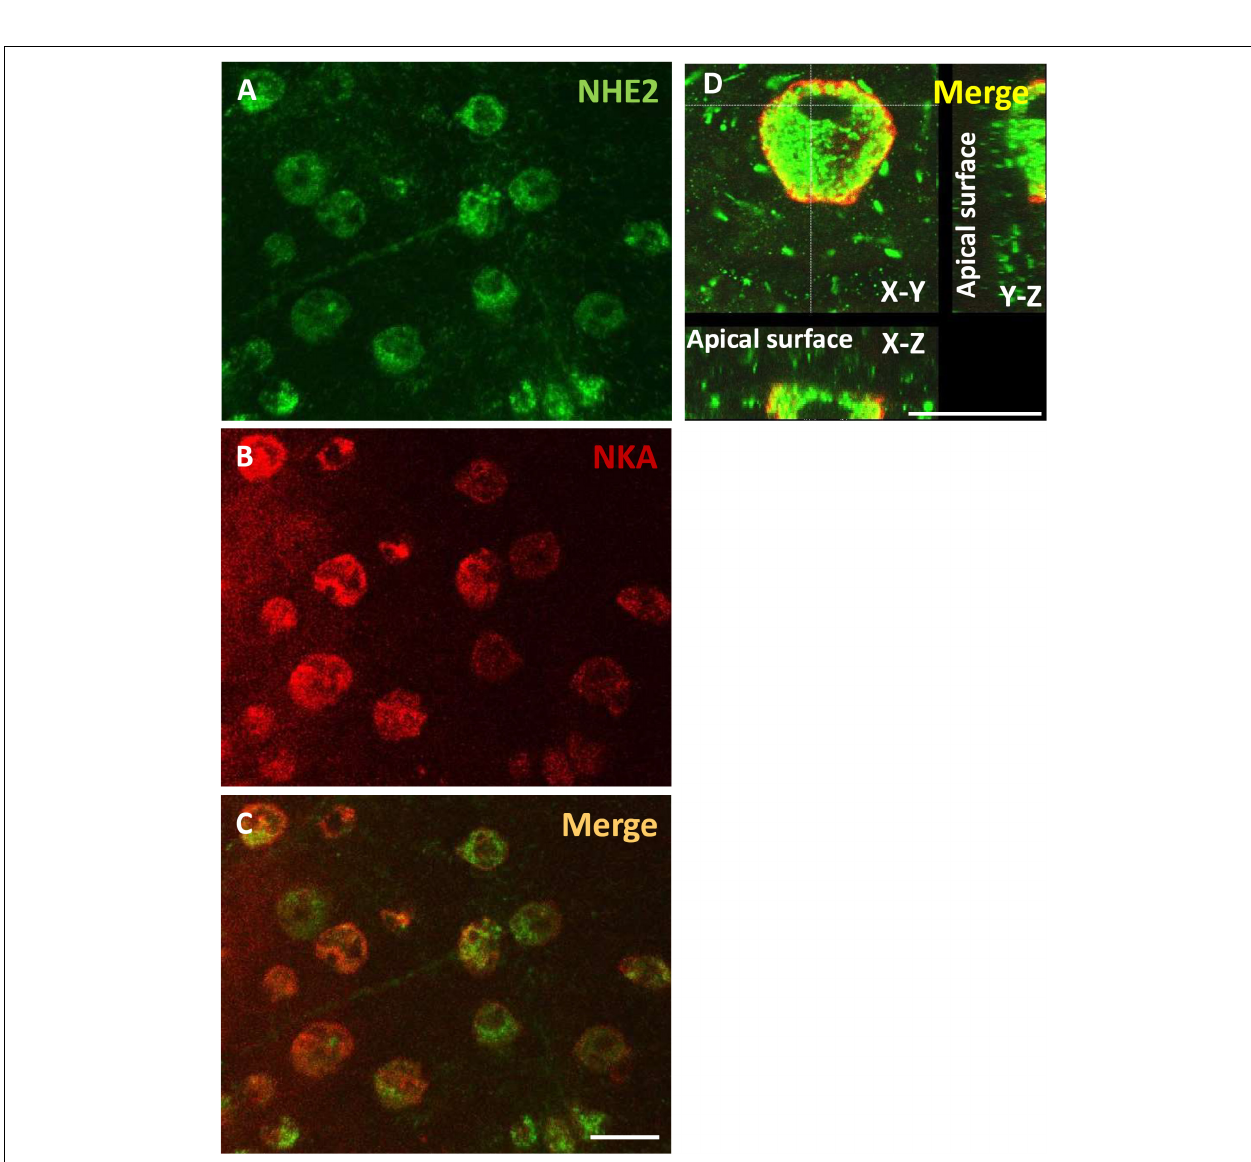
FIGURE 5 | Localization of Na + /H + exchanger 2 (NHE2) in the skin of seawater (SW)-acclimated medaka embryos. Immunocytochemistry of NHE2 (A) and Na + -K + -ATPase (NKA) (B) in 8-day post-fertilization (dpf) medaka embryos, as shown as merged images in (C,D) . Scale bar is 10 µ m.